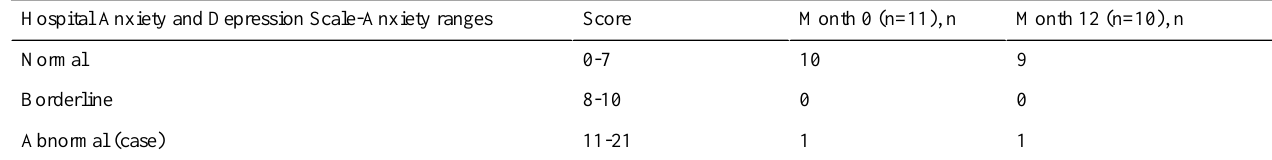
Table 13. Number of caregivers in each Hospital Anxiety and Depression Scale-Anxiety range group at months 0 and 12.